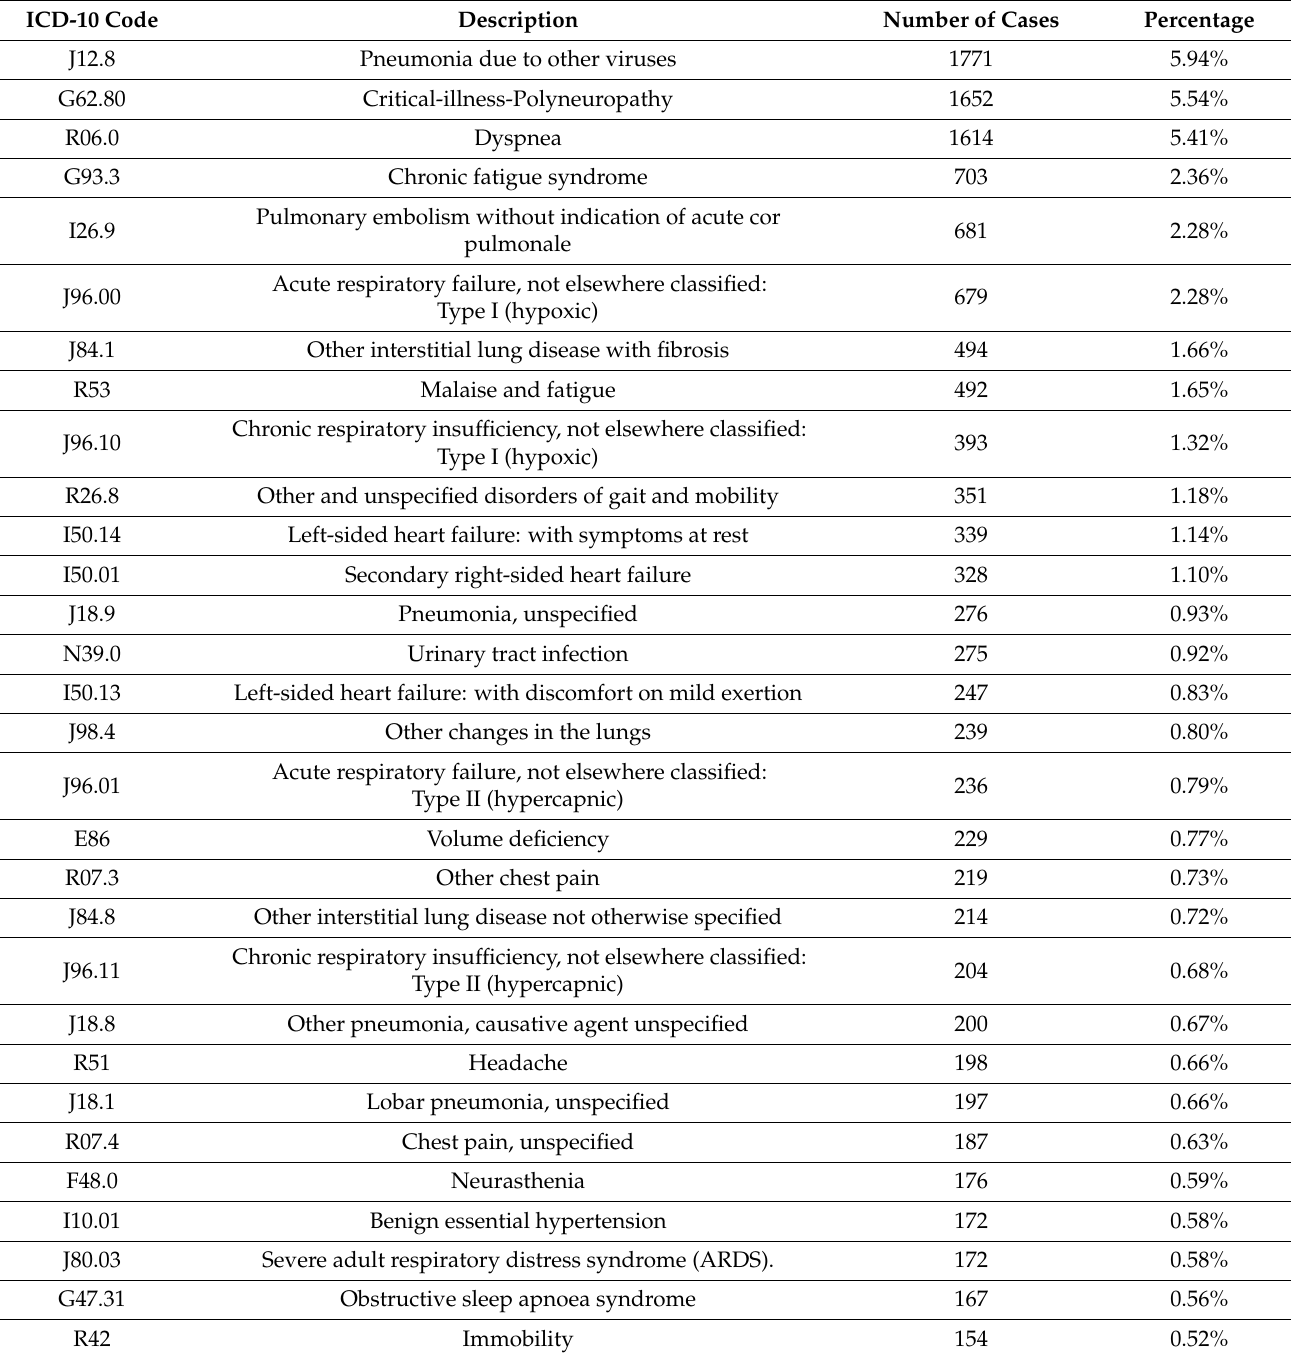
Table 2. Thirty main common primary diagnoses in association with Post-COVID